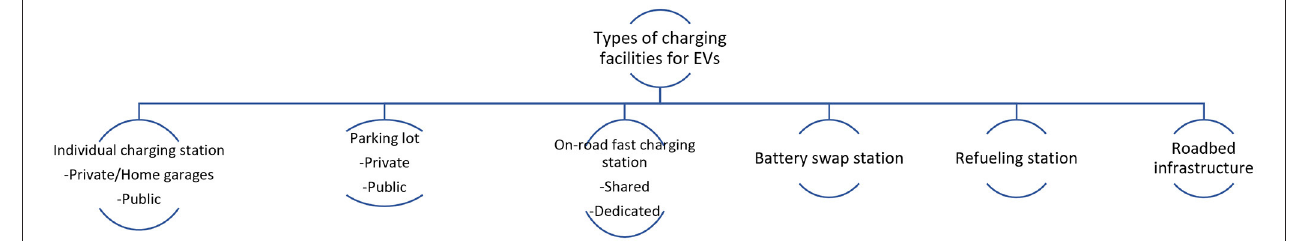
FIGURE 3 | The classification of the charging facilities for EVs adapted from Eider et al.